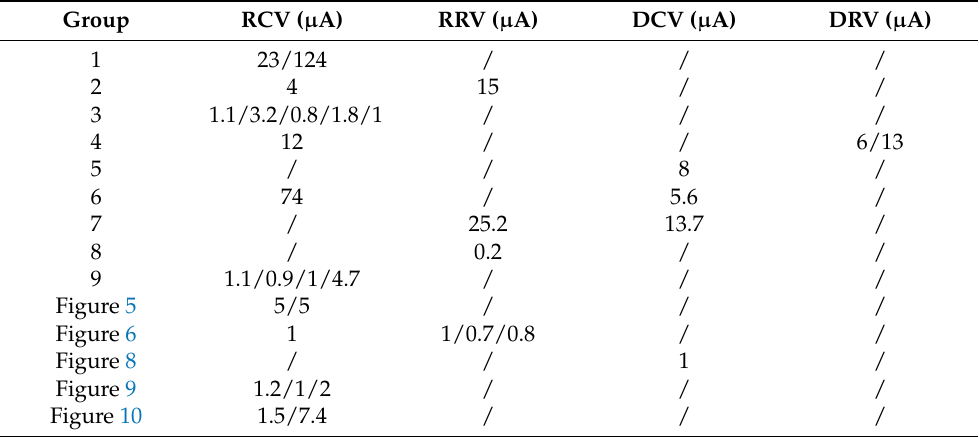
Table 1. The current change value in current–voltage